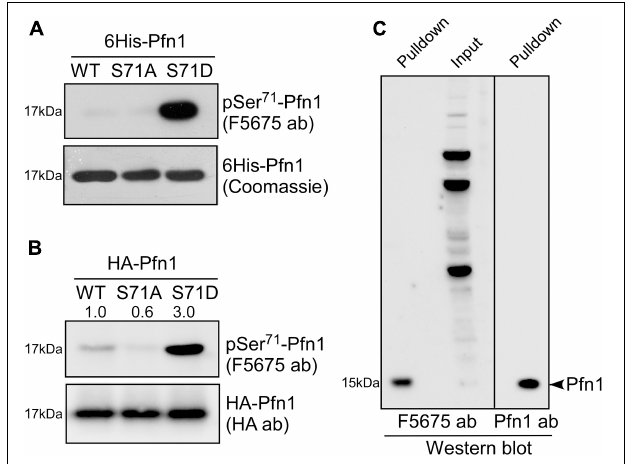
FIGURE 2 | Pfn1 is phosphorylated at Ser 71 in cultured cells. (A) Equal amounts of recombinant 6His-Pfn1 (WT, S71A, or S71) purified from bacteria was stained by Coomassie blue or analyzed by Western blot using the pSer 71 -Pfn1 antibody F5675. (B) HA-tagged Pfn1 (WT, S71A, or S71D) was transfected into HEK293 cells and immunoprecipitated using an anti-HA antibody. Samples were analyzed by Western blot using the pSer 71 -Pfn1 antibody (F5675) or the anti-HA antibody. Densitometry was used to quantify the intensity of bands detected by F5675 and expressed as relative values to HA-Pfn1(WT). (C) Endogenous Pfn1 was purified from MDA-MB-231 cell lysates using poly- L -proline (PLP)-conjugated agarose beads, and subjected to Western blot analysis using the pSer 71 -Pfn1 antibody (F5675) or a pan anti-Pfn1 antibody. Input was also blotted with the pSer 71 -Pfn1 antibody (F5675) for